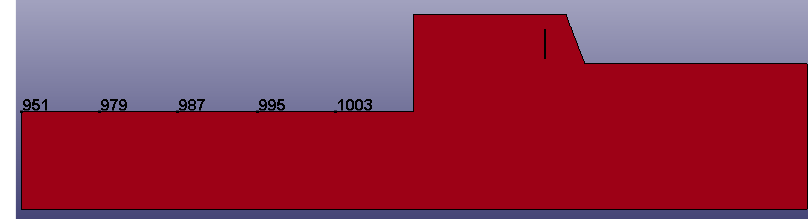
Figure 9. Layout of monitoring points at an elevation of 20 m.